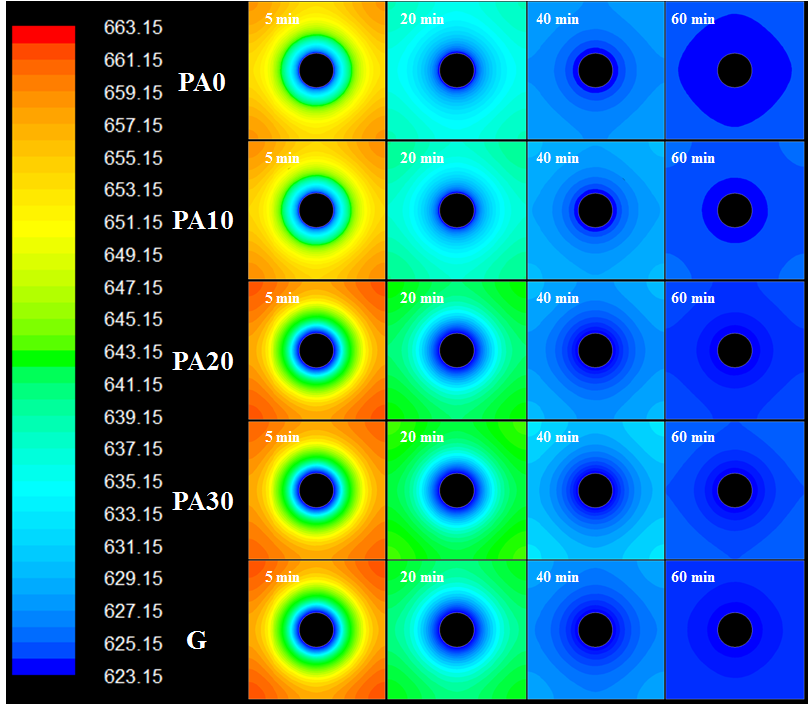
for tested materials, discharge tot